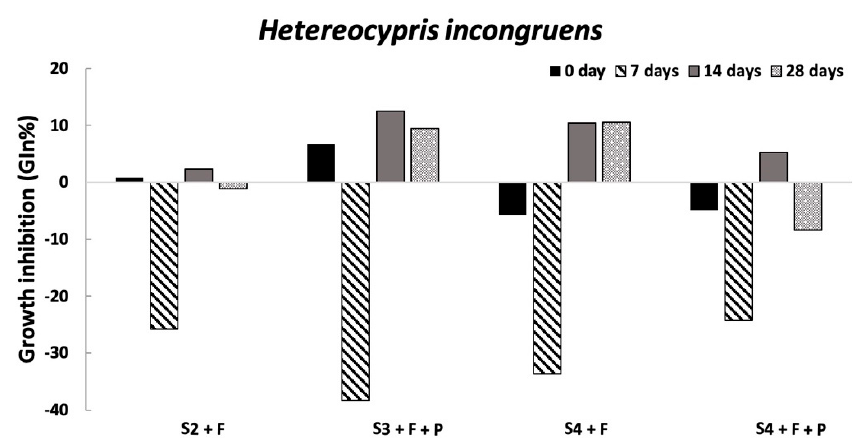
Figure 4. Growth inhibition (GIn%) of Heterocypris incongruens exposed to conditioned soils (S2 + F, S3 + F + P, S4 + F, S4 + F + P) at 0, 7, 14 and 28 days. The data are normalized to the controls (C2, C3, C4).